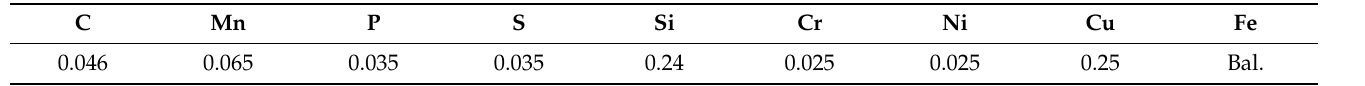
Table 1. Chemical composition of 45# steel